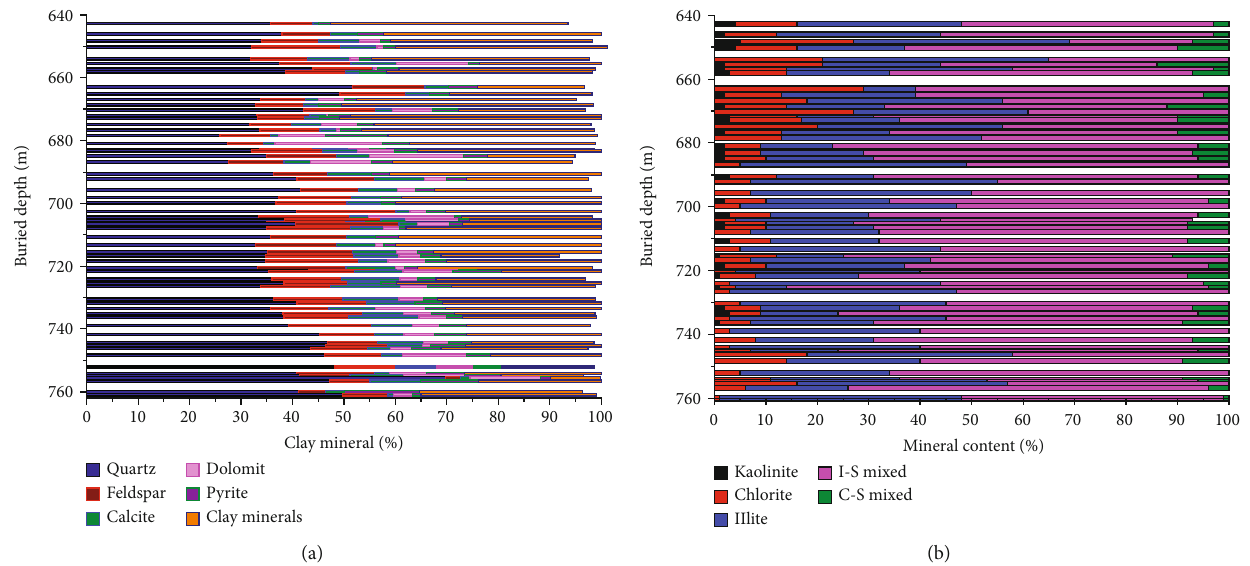
Figure 3: Mineral composition (a) and clay mineral analysis (b) of shale samples from Well-YC4. I-S: illite-smectite mixed-layer mineral; C- S: chlorit -smectite mixed-layer mineral.